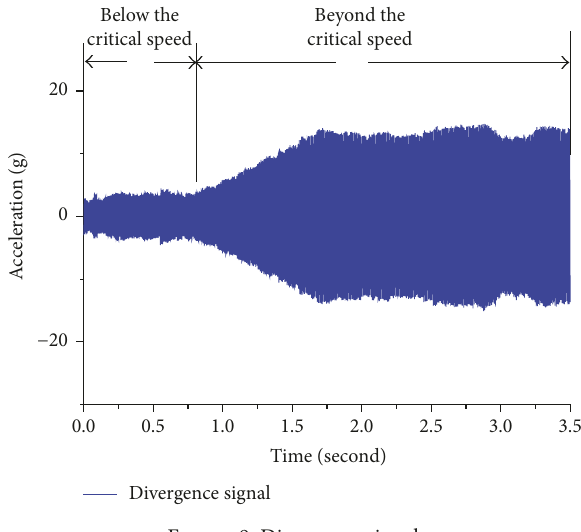
Figure 9: Divergence